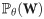
Viewing mechanistic neuronal circuit models as generative models for tuning curves.(A) Schematic representation of a generic recurrent circuit model from theoretical neuroscience. The network structure, in this case reduced to the full recurrent connectivity matrix W, is partially random with statistics described by the distribution Pθ(W), which depends on parameters θ. These parameters could, e.g., include the average strength or spatial range of connections between different cell types. The network receives an external input, I(s), that represents stimuli, which can be in one of S different conditions employed in an experiment. The output of the model is taken to be the sustained response, r¯(s), of a pre-selected probe neuron (blue arrow). Given a realization of the network structure W (sampled from Pθ(W)), this response can be obtained in each stimulus condition, s, by simulating the network in the presence of external input I(s). The responses, r¯(s), for all stimulus conditions are then concatenated into a tuning curve vector x=(r¯(1),⋯,r¯(s)), which is the ultimate output of the network when viewed as a generative model. (B) The deterministic mapping f stands for the simulation process that links the particular realization of the network structure W to its functional (tuning curve) output x. Since the ultimate goal is to use gradient-based methods to learn the model parameters, θ, the process of sampling a realization of W is cast (cyan area) using a parametrized mapping, gθ, that transforms a set of standard noise variables z, sampled from a fixed distribution, into W. The composition of f and gθ yields the full parametrized generator function, Gθ ≡ f ◦ gθ, as used in the GAN framework (bottom row). Given a set of parameters, the generator thus receives a set of noise variables, z, sampled from their standard distribution, and generates a tuning curve, x.